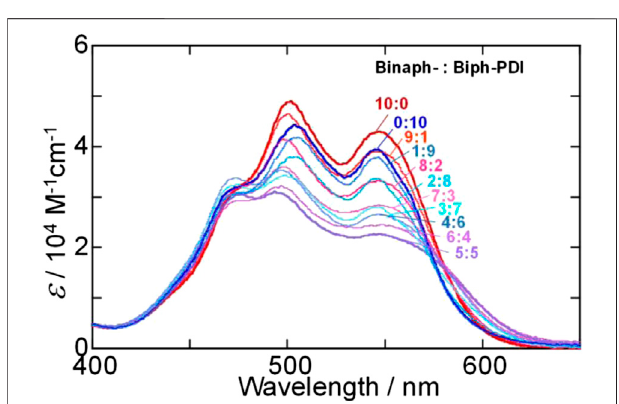
FIGURE 5 | Absorption spectral change of Biph-PDI-( S )-Binaph-PDI coassembliesina mixture (1:19) ofchloroform/MCH [Biph-PDI] +[( S )-Binaph- PDI] (cid:1) 3.0 × 10 – 5